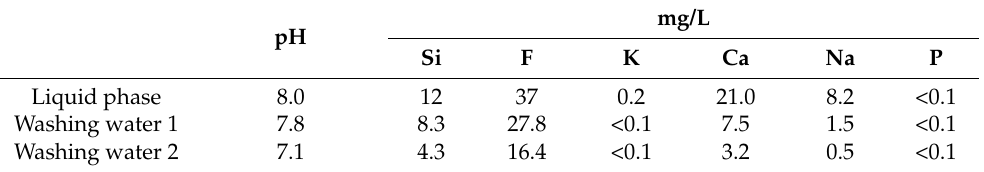
Table 4. Characterization of the liquid phase of sludge after treatment with lime. mg/L pH Si F K Ca Na